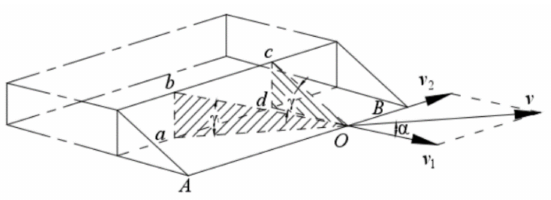
Figure 13. Sliding cut